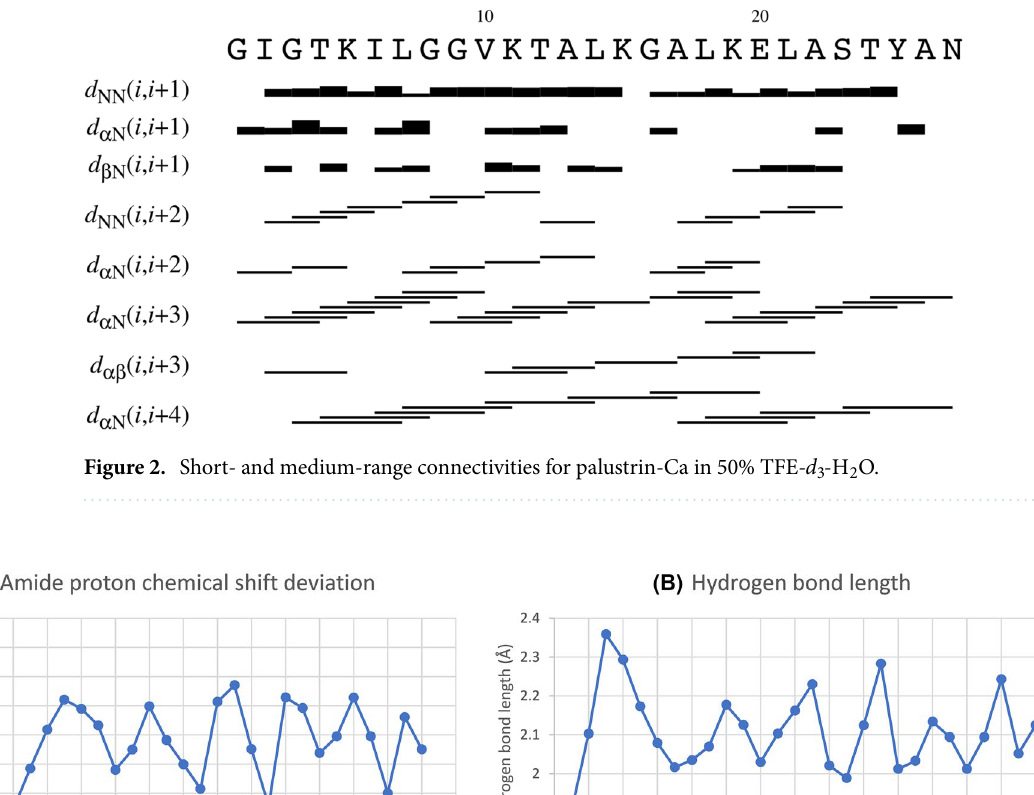
− 3 − 2.3 ), where d N N